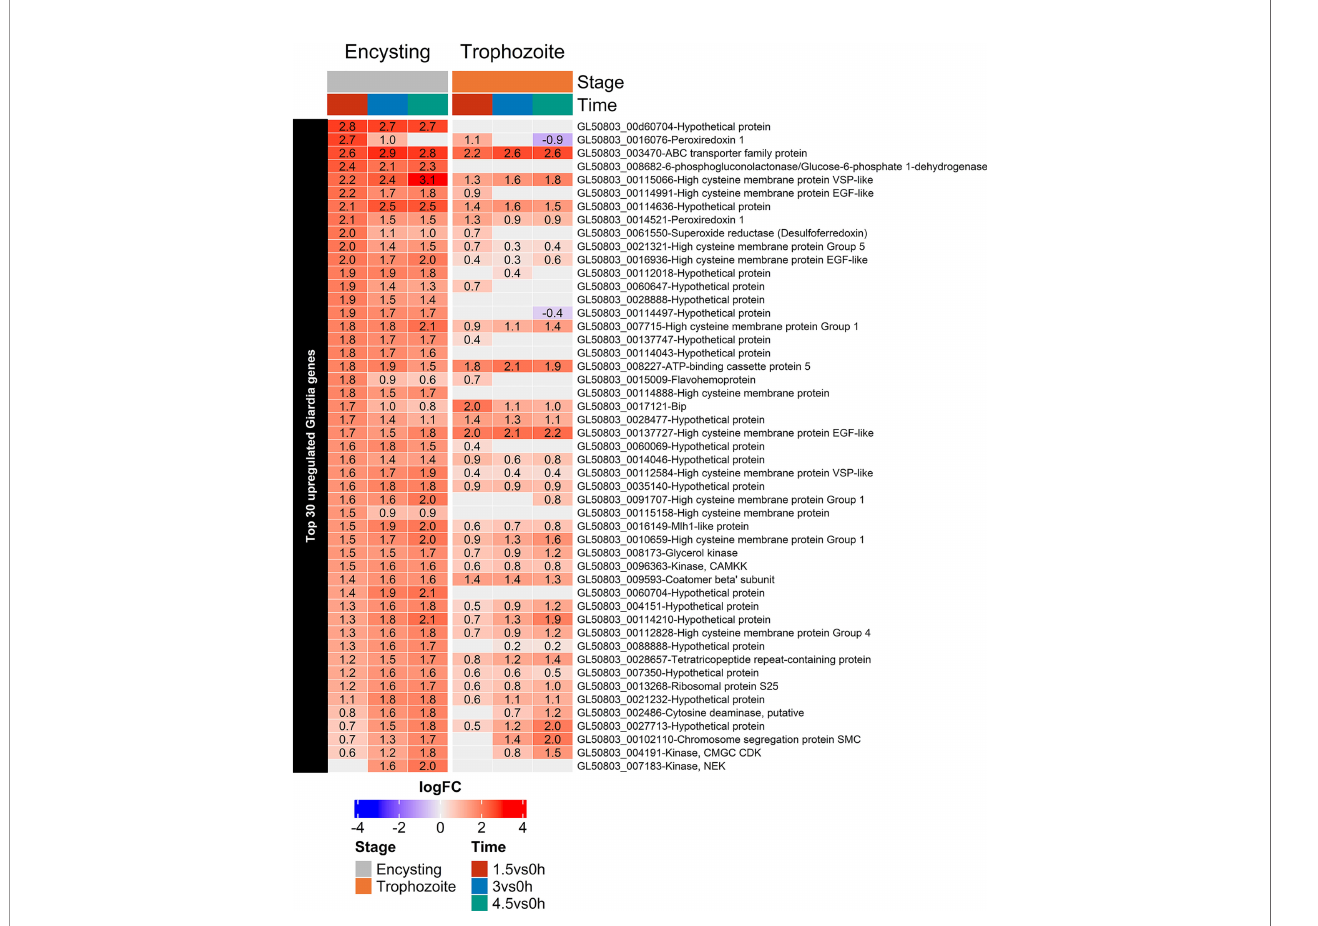
FIGURE 6 | Heatmap of the top 30 up-regulated genes in encysting Giardia cells during Caco-2 infections at timepoints 1.5, 3, and 4.5h during Caco-2 infection compared to trophozoite differentially regulated genes at the same infection timepoints. Only signi fi cant values are shown, insigni fi cant values are set